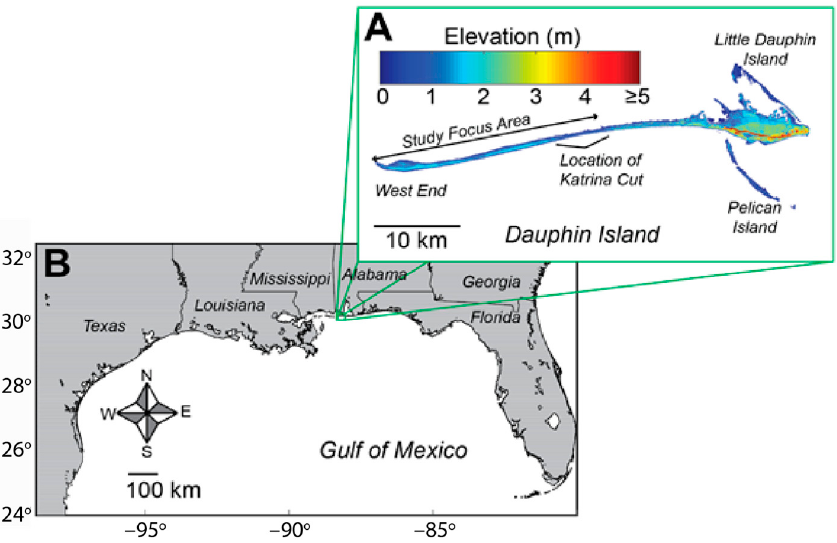
Figure 1. Location of Dauphin Island ( A ) within the northern Gulf of Mexico ( B ) (modified from [21]).